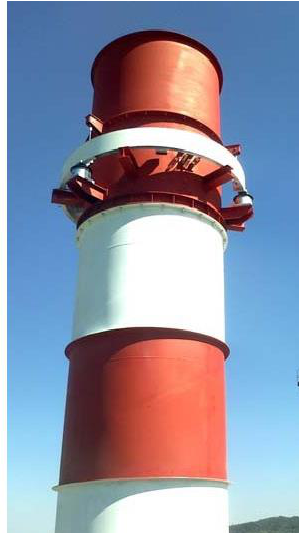
Figure 2. Arquata Scrivia chimney (AL, Italy). An example of applying an auxiliary and reversible system that changes its response under dynamic loads (solution 2).